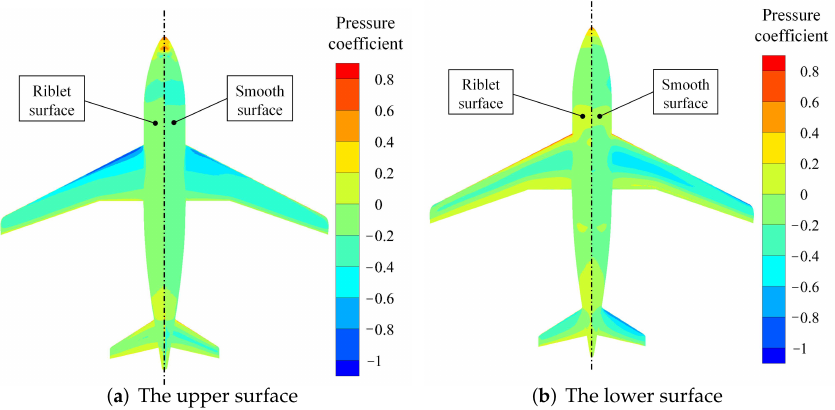
Figure 27. Pressure distributions on the ribleted model and the baseline model.